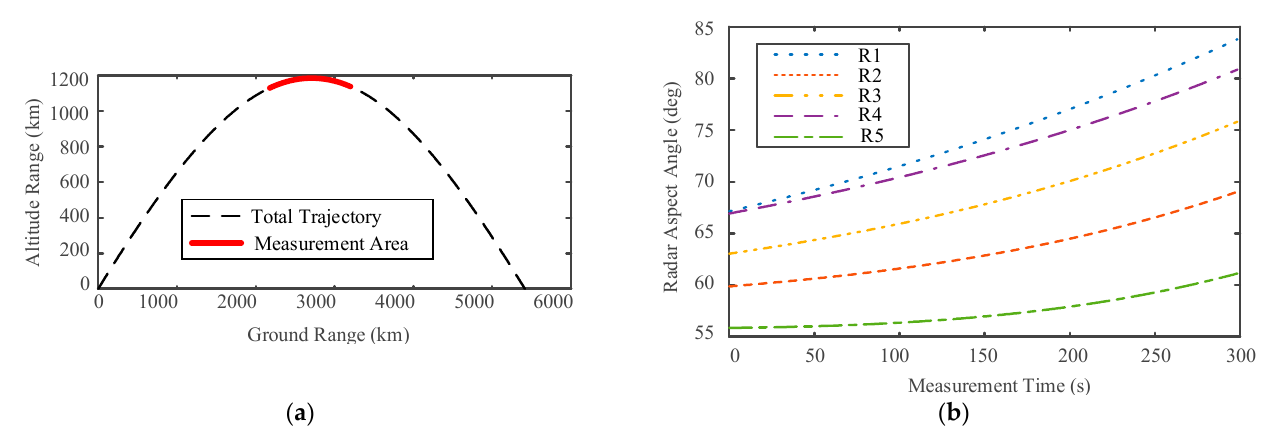
Figure 7. Ballistic missile trajectory and radar network simulation data: ( a ) model of ballistic missile trajectory; ( b ) multiple radar observation angle sequence.